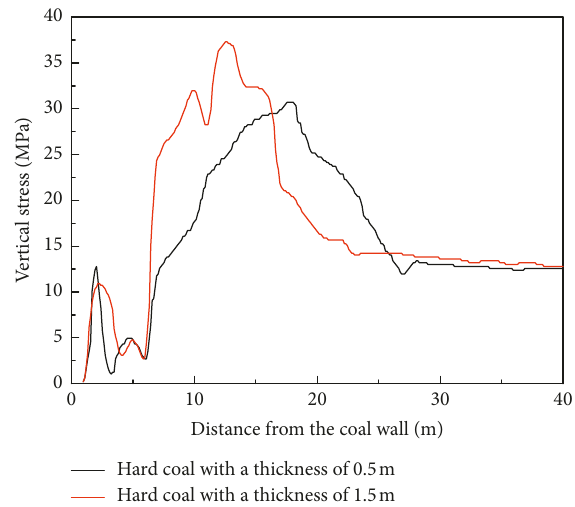
Figure 3: Vertical stress of the coal body in front of coal wall with different thicknesses of hard coal